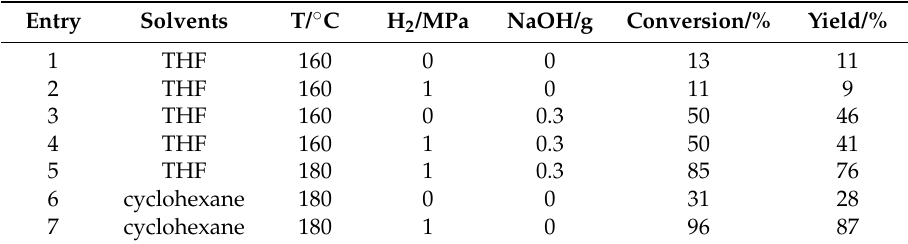
Table 5. Conversion of cyclohexanol into cyclohexylamine over Ni/Al 2 O 3 in tetrahydrofuran (THF) and cyclohexane.